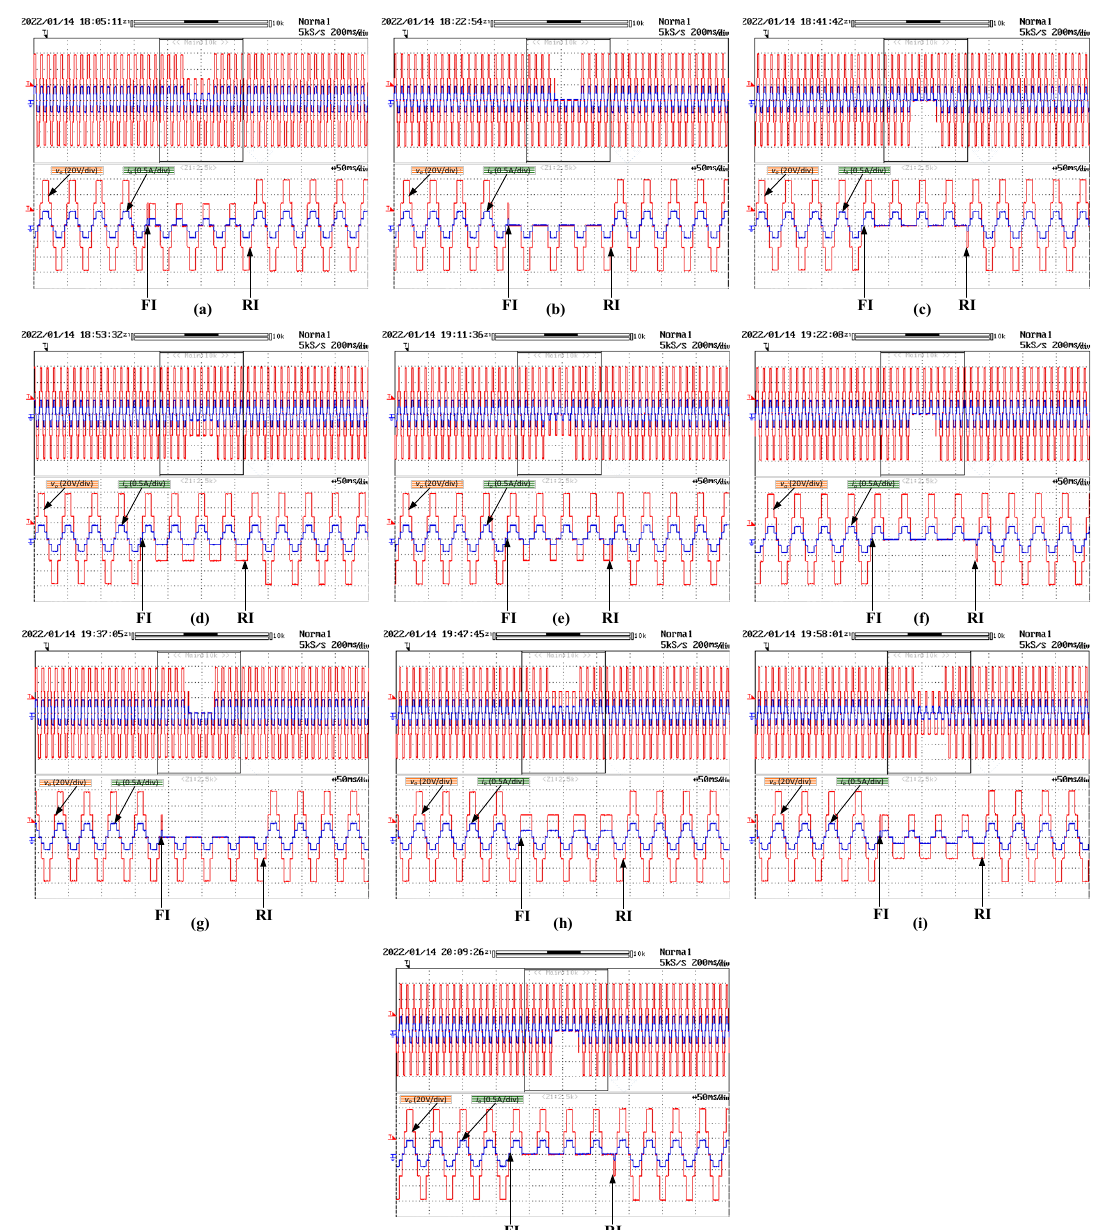
Figure 54. Experimental results (output voltage, v o ; and load current, i o ) for FT operation of the topology in the case of single-switch OC fault for switch ( a ) A 1 , ( b ) A 2 , ( c ) A 3 , ( d ) A 4 , ( e ) B 1 , ( f ) B 2 ( g ) B 3 and ( h ) B 4 ; and multiple-switch OC fault for switches ( i ) A 1 and A 4 and ( j ) A 4 and B 1.